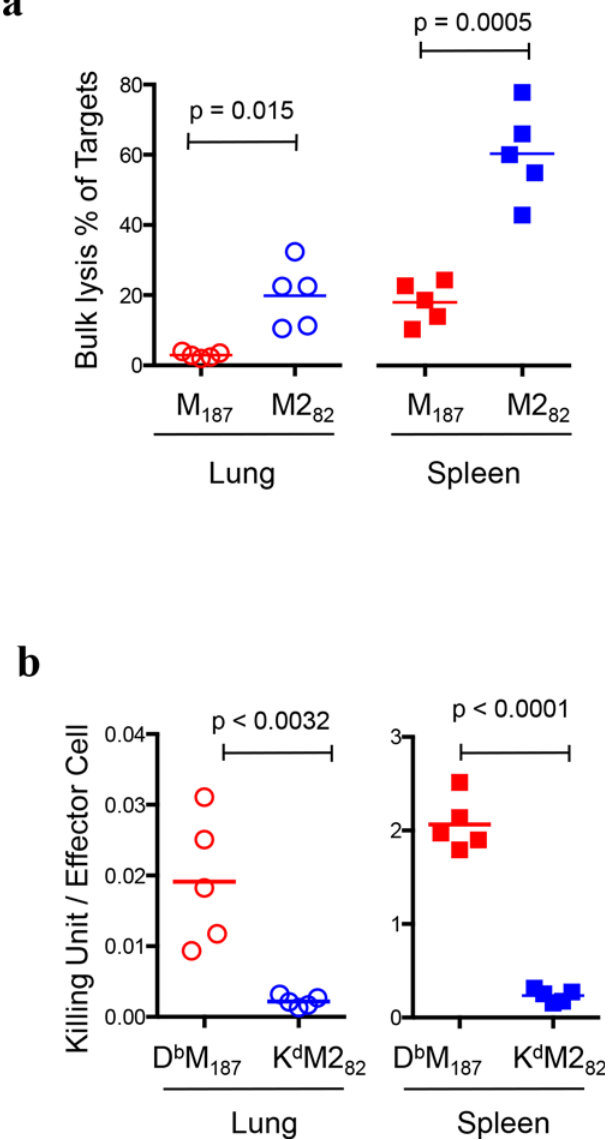
Fig 2. K d M2 82 T cells dominate bulk cytotoxicity but D b M 187 T cells have superior individual cytotoxicity. ( a) Bulk cytotoxicity of D b M 187 and K d M2 82 T cells in vivo . The epitope peptide-loaded and fluorochrome-labeled targets, as well as OVA 257 peptide-loaded and fluorochrome-labeled controls, were co- transferred into RSV-infected mice at 7dpi, and recovered 3 hours later. The recovery ratio were assessed with flow cytometry and compared with recovery ratio from na ï ve recipients to calculate epitope-specific lysis. Data represent 5 independent experiments (n = 5/group/experiment). (b) Cytotoxicity of individual D b M 187 and K d M2 82 T cells. Ratio of specific lysis of donor targets in (a) was divided by frequency of endogenous D b M 187 and K d M2 82 T cells respectively to quantitatively express arbitrary “ Killing Unit ” of individual cells. Data represent 5 independent experiments (n = 5/group/experiment). All data are shown as mean with independent data point and compared by Student t-test. Each symbol represents one